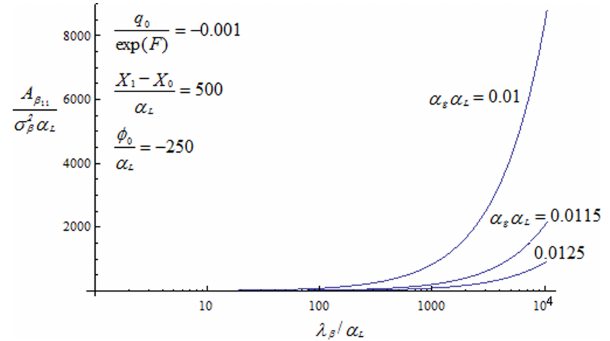
Fig. 2. Dimensionless component of the longitudinal macrodisper- sivity as a function of dimensionless ln α correlation scale.